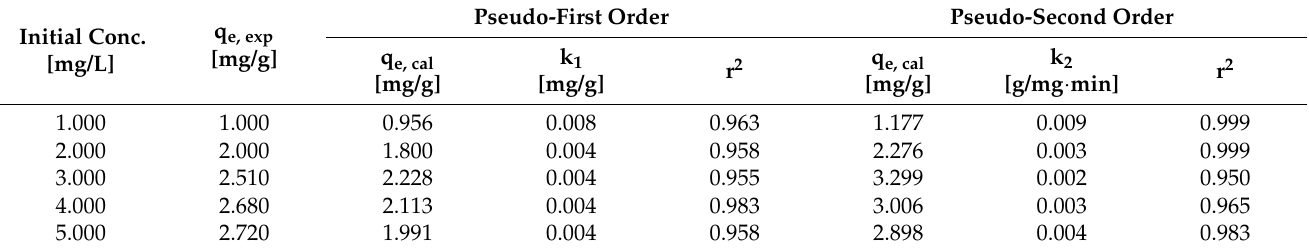
Figure 6. Linear adsorption kinetic models of NH 4 -N adsorption on MSSB at different initial NH 4 -N concentrations: ( a ) Pseudo-first order equation, ( b ) Pseudo-second order equation. Table 4. Parameters of kinetic model for NH 4 -N adsorption onto